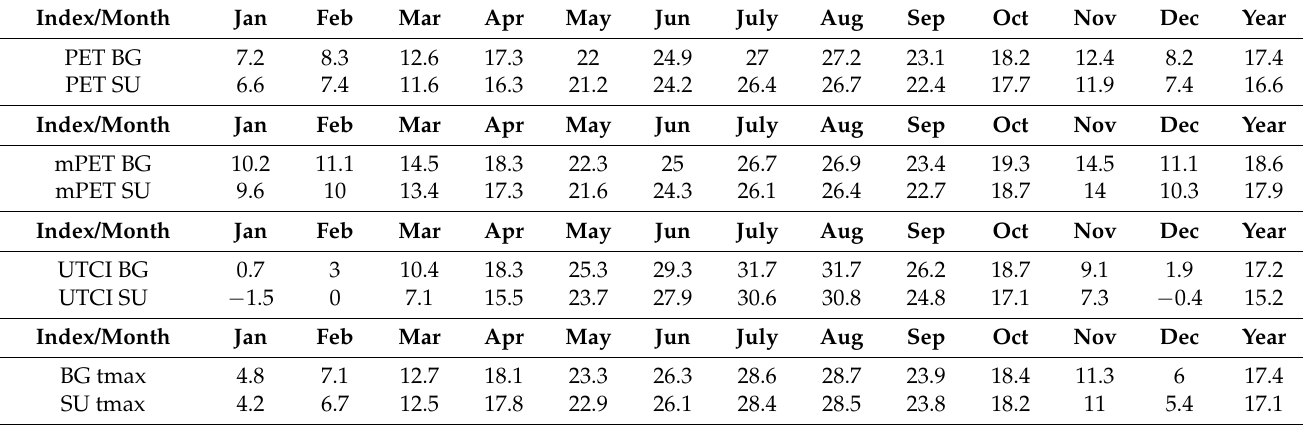
Table 3. Average monthly and annual PET, mPET and UTCI in Belgrade (BG) and Surcin (SU) for the period 1976–2018 at 14 h (CET).